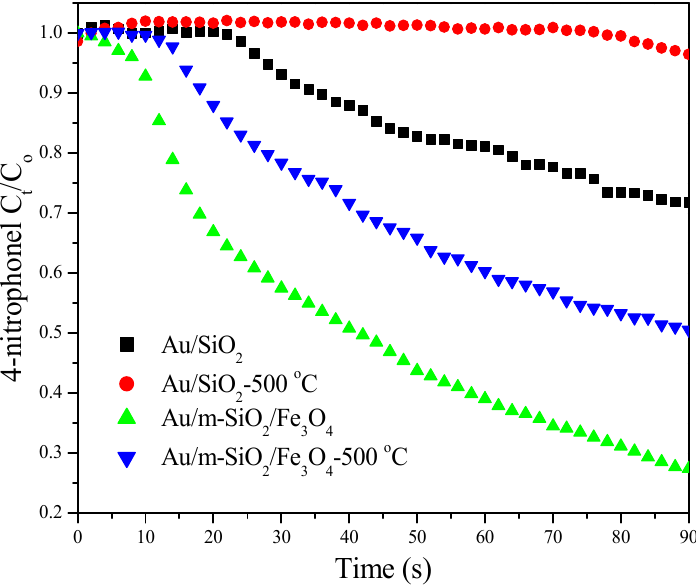
Figure 7. Decrease in p -nitrophenol’s relative concentration during the hydrogenation reaction using different